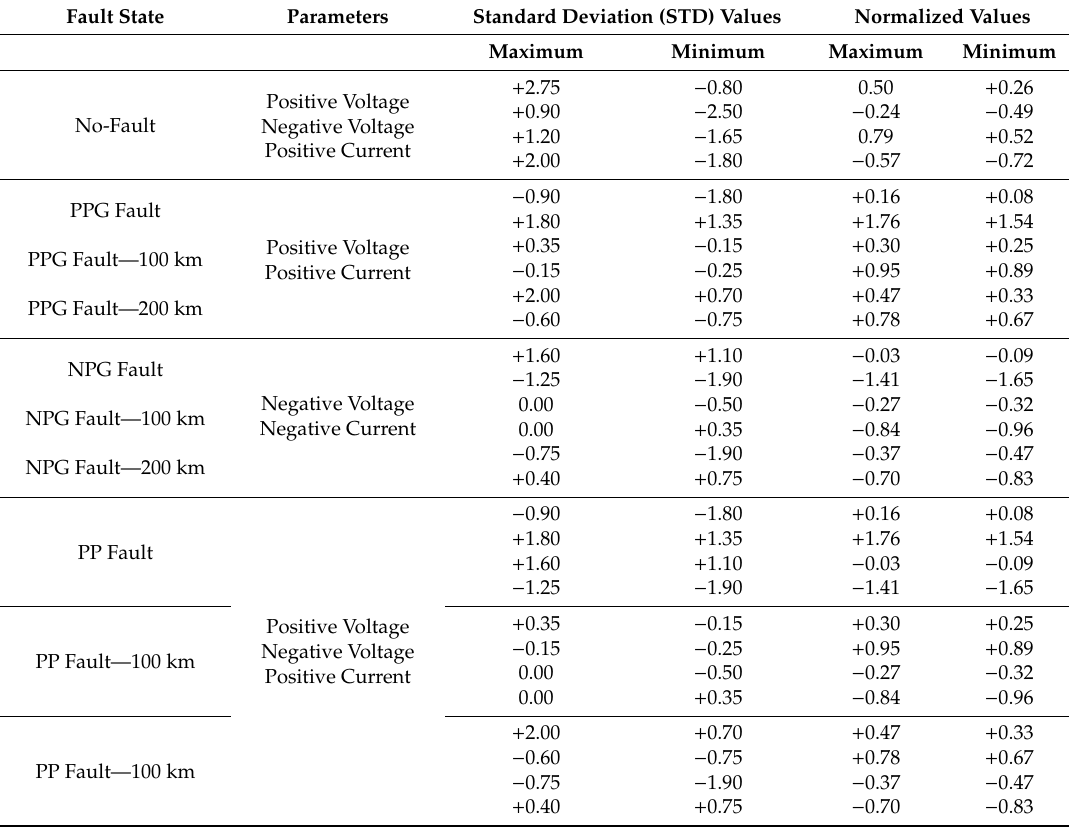
Table 3. Relative maxima and minima of standard deviation and normalized DC voltage and current values for fault location